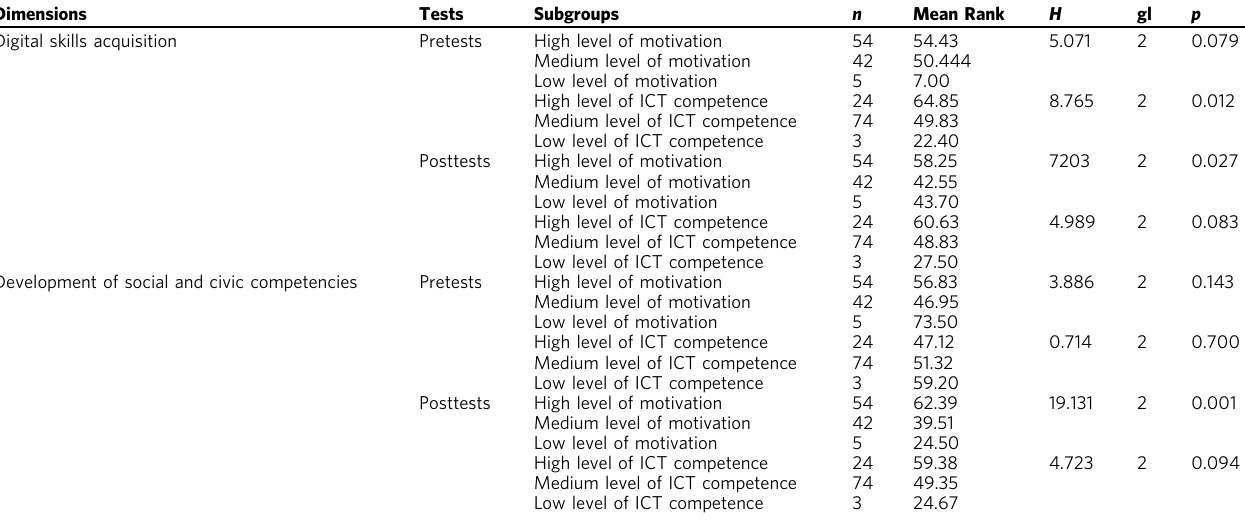
Table 5 Results of the kruskal-wallis test on the acquisition of digital skills and social and civic competencies.